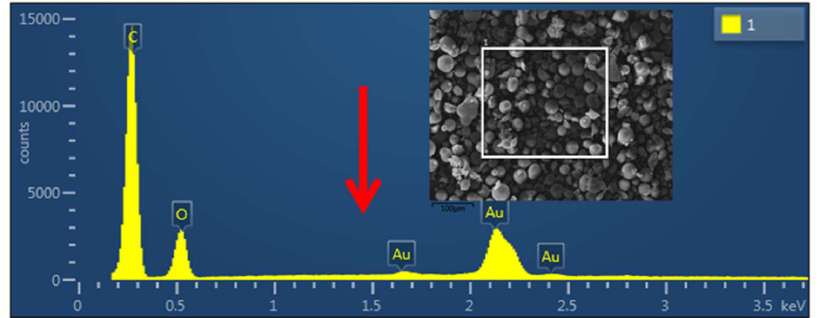
Figure 5. The EDS results of the MIMS after SiO 2 removing.